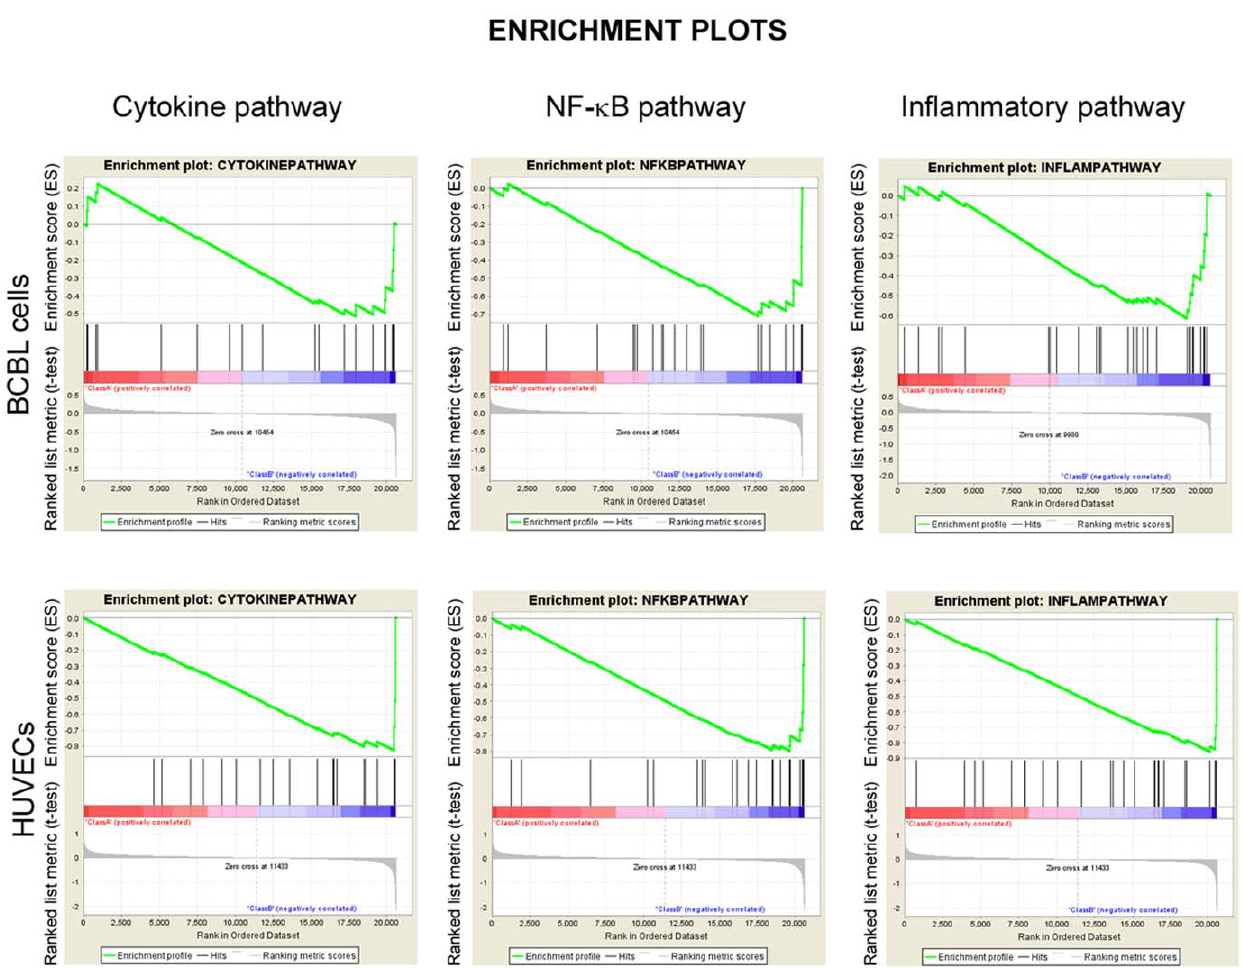
Figure 1. Gene set enrichment analysis. For Gene set enrichment analysis of signatures genes from BCBL1-K13 (top panel) and HUVEC-K13 (lower panel), the t-test was graphed for each correlated gene in the ranked dataset. Three GSEA enrichment plots for representative biological pathways (Cytokine, NF- k B and Inflammatory) enriched in 4OHT-treated BCBL1-K13-ER TAM and HUVEC-K13-ER TAM are shown. The top portion of each GSEA plot shows the running enrichment score for validated genes specific for particular pathway as it moves down the ranked list. The bottom portion of each plot shows the value of ranking matrices as it moves down the list of ranked genes. The red horizontal bar which terminate with blue color indicate shift from positively correlated genes (red) to negatively correlated genes (blue). Further detailed interpretation about these plots can be found at Broad Institute web site (http://www.broadinstitute.org/gsea/index.jsp). doi:10.1371/journal.pone.0037498.g001 PLoS ONE |